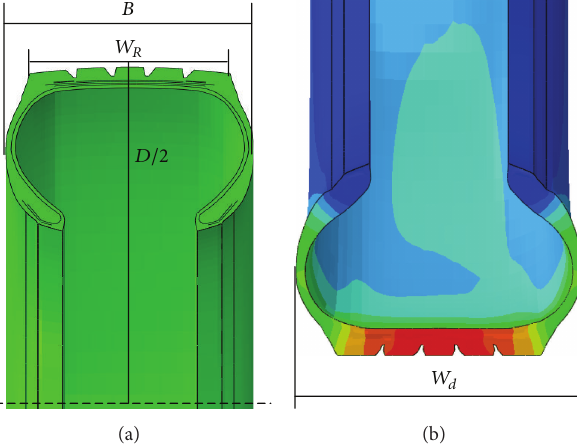
Figure 3: (a) Section of tire inflated state. (b) Deformation of the lowest section of tire.